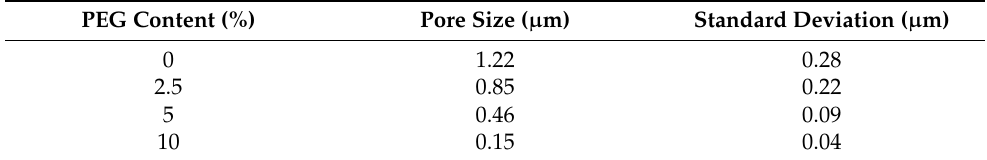
Table 2. The pore size of the casted films after contact with scCO 2 for 24 h at 170 bar and 35 ◦ C.